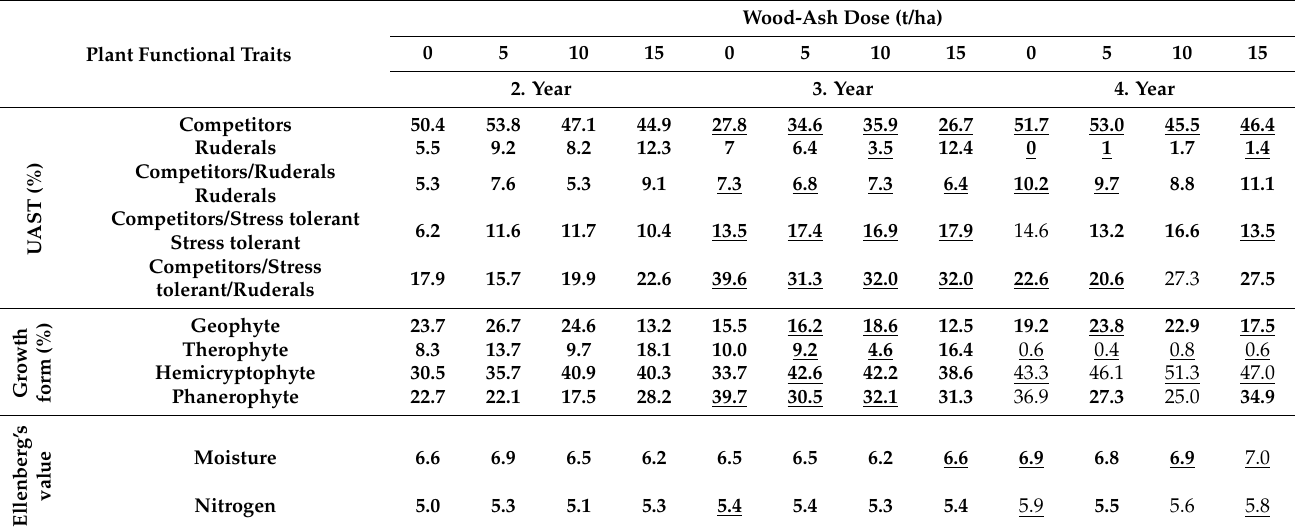
Table 2. There was a tendency for geophyte cover to be lower under the highest fertiliser dose, independent of location; Figure A1. Although no significant changes occurred, the mean hemicryptophyte cover was higher in the plots 0.5–4 m from the ditch. Table 1. Relative cover (proportion of total cover) of plants by strategy (UAST) and growth form and community weighted mean values for Ellenberg’s indicator values in plots depending on the dose of wood-ash fertiliser during the observation period. Underlined text indicates significant differences in 3rd and 4th year of research with previous season and bold text indicates significant differences between 2nd and 4th year of research (Student’s t -test ( p < 0.05)).